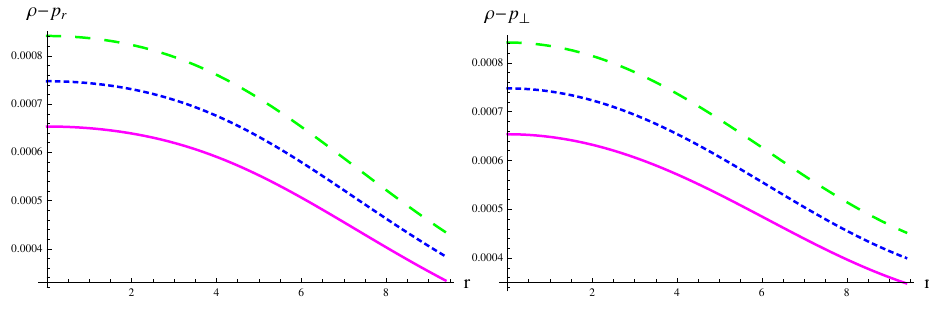
Figure 13. DEC for extended solution II for Υ = 0.2.